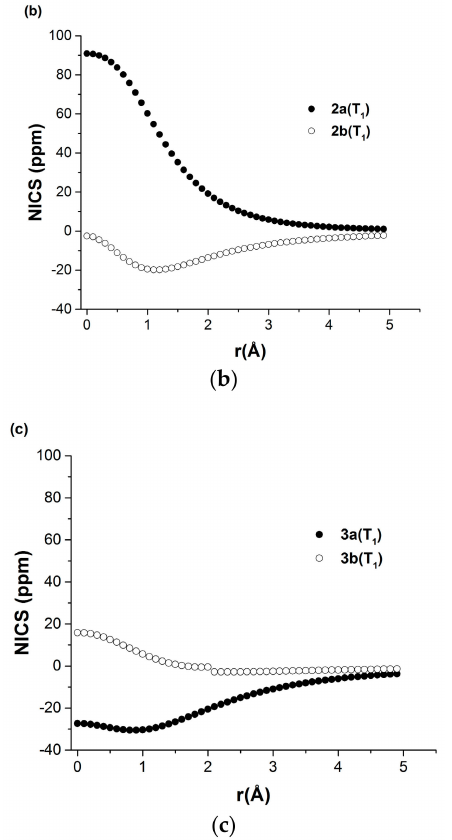
Figure 6. Nucleus independent chemical shifts (NICS) scans of ( a ) 1a ( T 1 ) and 1b ( T 1 ); ( b ) 2a ( T 1 ) and 2b ( T 1 ); as well as ( c ) 3a ( T 1 ) and 3b ( T 1 ) at the GIAO-(U)B3LYP/6-311+G(d,p)//(U)B3LYP/6-311G(d,p) level. Only the out-of-plane components are